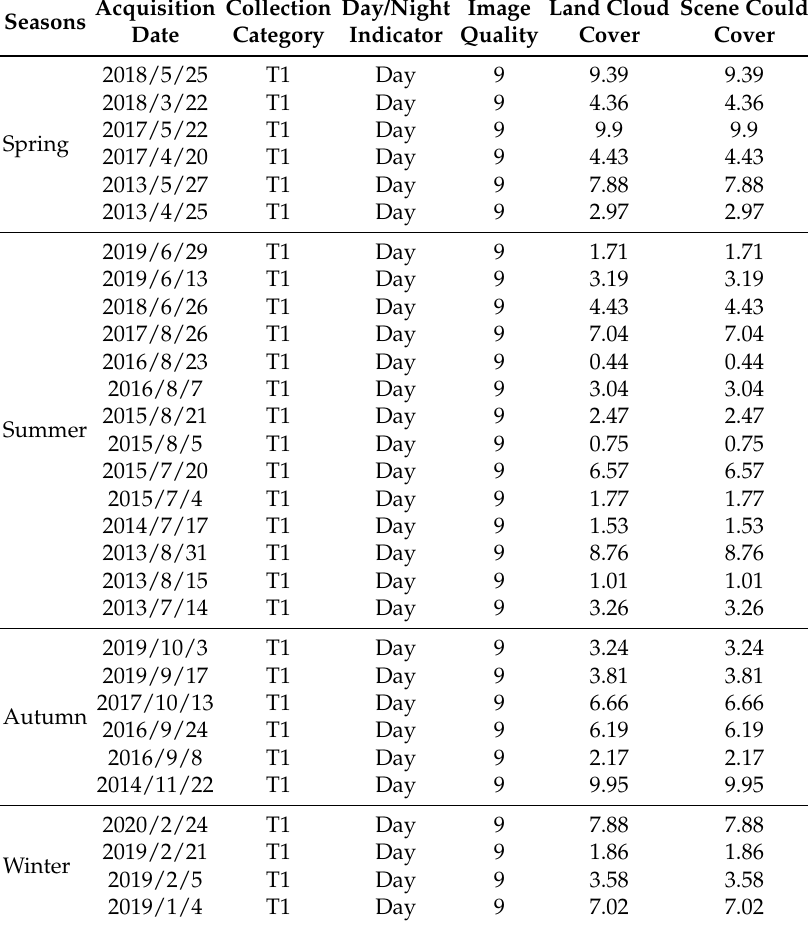
Table A1. The characteristics of Landsat imagery for